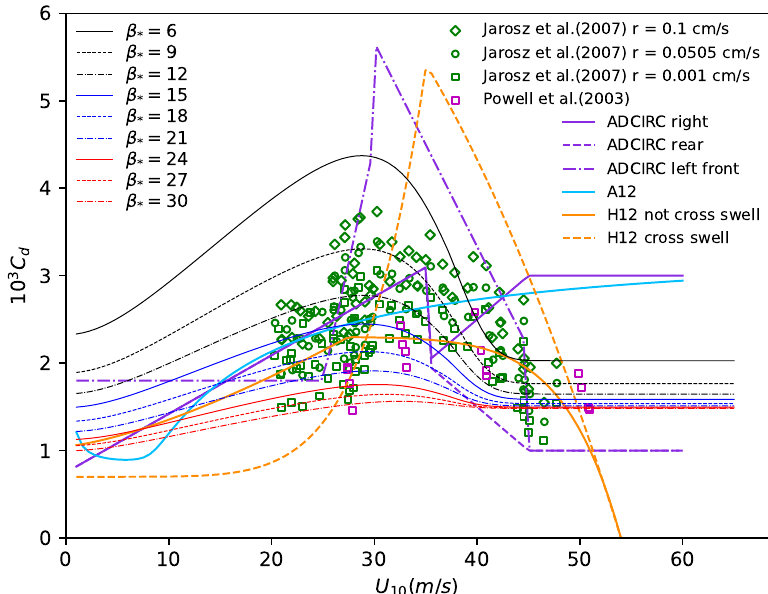
Figure 10. As in Figure 8c, but the curves of ADCIRC, A12, and H12 are